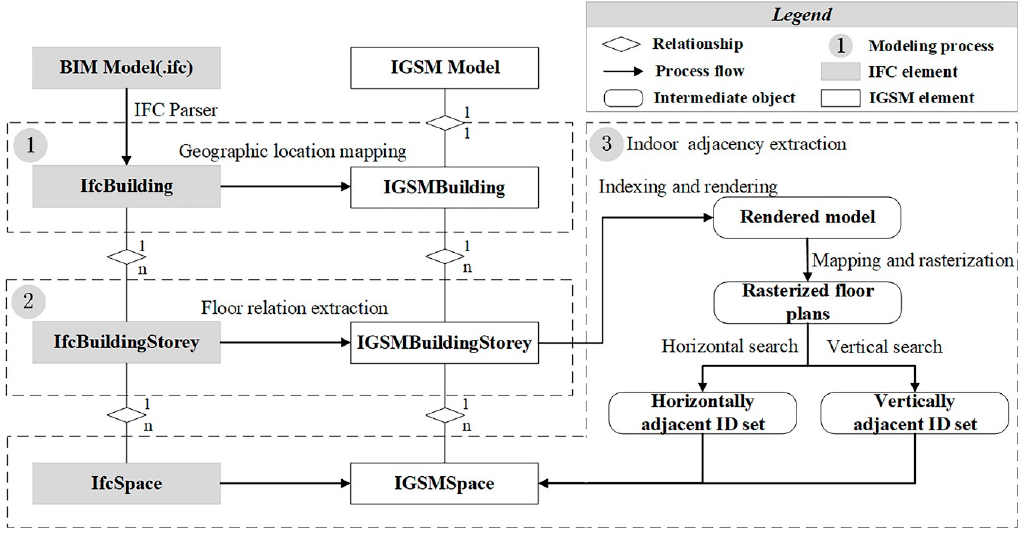
Figure 8. Workflow of IGSM modeling algorithms.